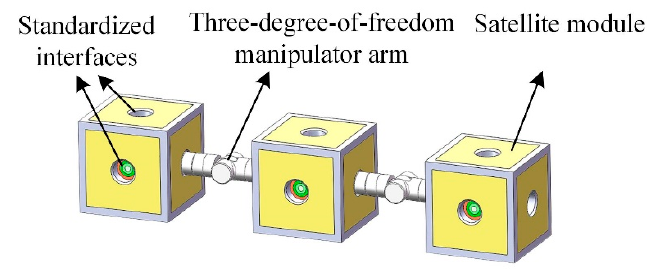
Figure 1. Modular self-reconfigurable satellite.